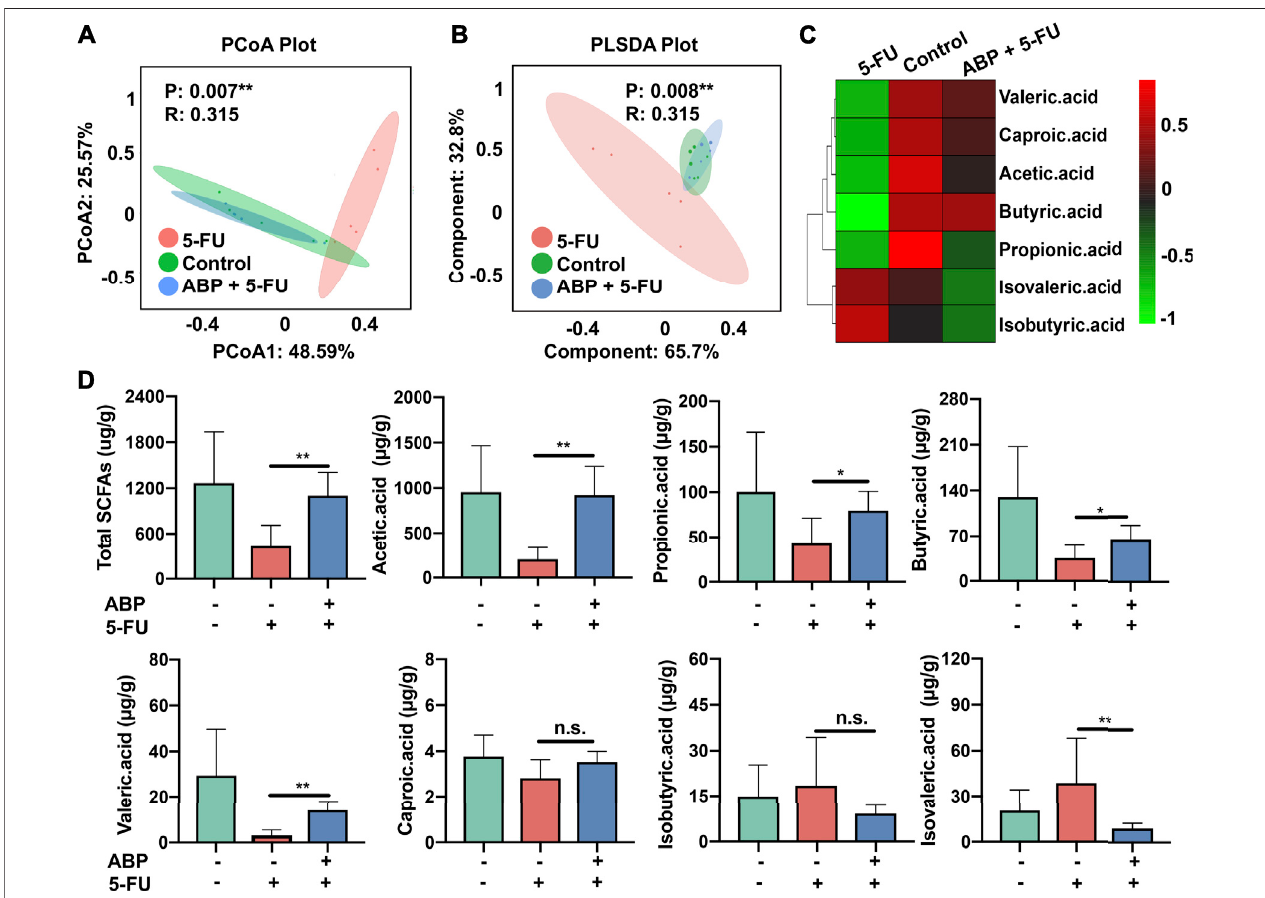
FIGURE9| ABPtreatmentimprovestheconcentrationsoffecalshort-chainfattyacidsinCRCmodelmice. (A-B) PCoAandPLS-DAanalysis. (C-D) Heatmapand Bar plots for fecal SCFA content. * p < 0.05, ** represents p < 0.01.